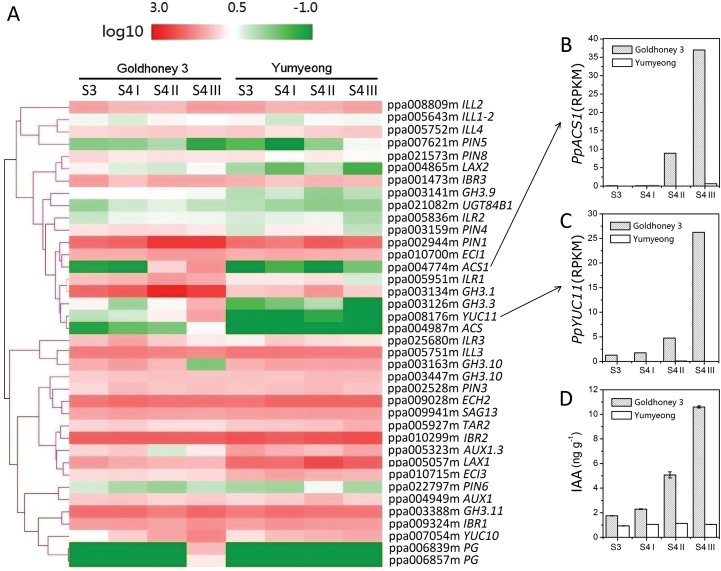
Hierarchical cluster analysis of auxin-homeostasis-related genes in peach undergoing ripening. (A) Hierarchical cluster analysis of 34 auxin-homeostasis-related genes and four ripening-related gene expression levels in ‘Goldhoney 3’ and ‘Yumyeong’; peach fruits were sampled at the S3, S4 I, S4 II, and S4 III stages. The log10 ratios and scale bars are shown in the resulting tree figure, which was obtained using the CLUSTER software package and Java Treeview. The DGE profiles of these genes are listed in Supplementary Table S3 at JXB online. (B) RPKM of PpACS1, (C) RPKM of PpYUC11, and (D) IAA concentrations in ‘Goldhoney 3’ and ‘Yumyeong’. Data are means ±SE of three individual experiments, each performed in triplicate. (This figure is available in colour at JXB online.)